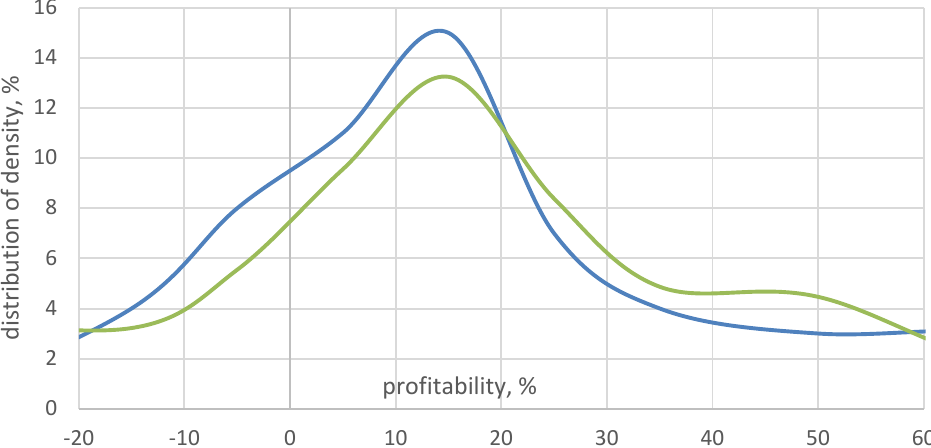
Fig. 3: Identification of crop production profitability distribution (according to the combined sample). Blue line - actual distribution, gray line - Laplace distribution Table 2: Checking the hypothesis about Laplace distribution according to Pearson criterion Parameters